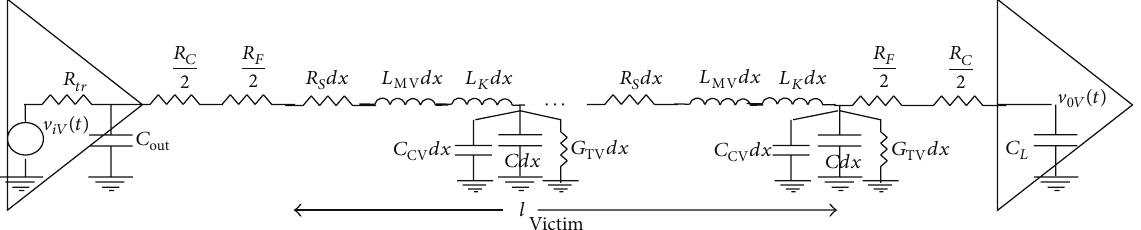
Figure 5: Equivalent circuit model for a driven victim CNT interconnect (an outer shell or inner shell of a MWCNT) as a victim line, with considering the impact of aggressor line, using transmission line modeling.